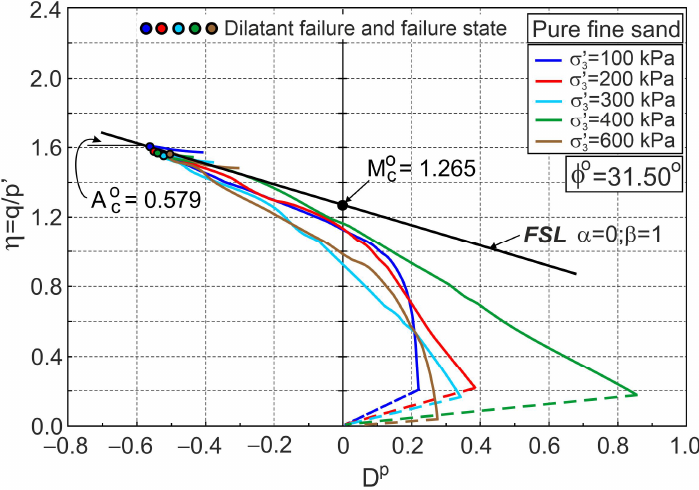
Figure 3. Stress ratio–plastic dilatancy relationships for pure sand(based on the experimental data from [5]).